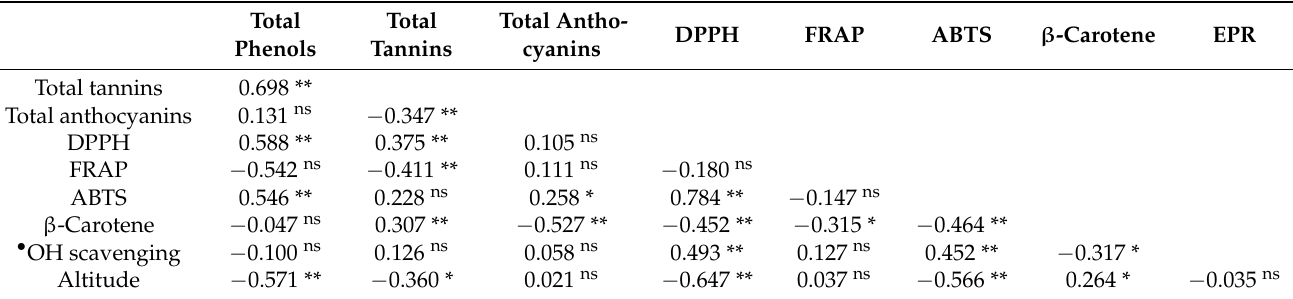
Table 8. Correlation coefficient (r) calculated between the phenolic compounds content analysed, antioxidant activity (AA) obtained with the different assays, developmental stages (DAF), and altitude in myrtle berries in berry extracts. Significance: ** = p ≤ 0.01; * = p ≤ 0.05; ns = not